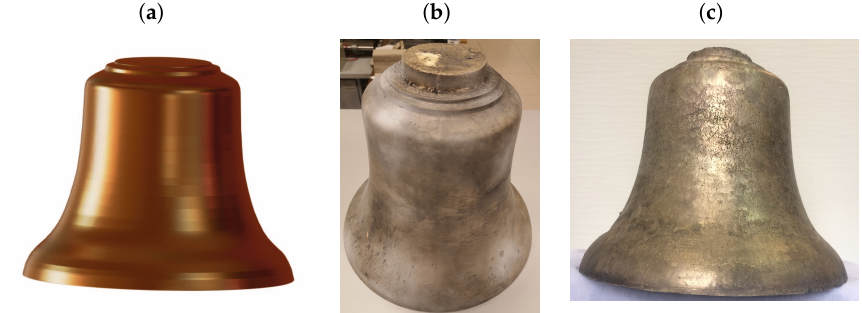
Figure 4. Analyzed bells: ( a ) CAD model; ( b ) CuSn20; ( c )